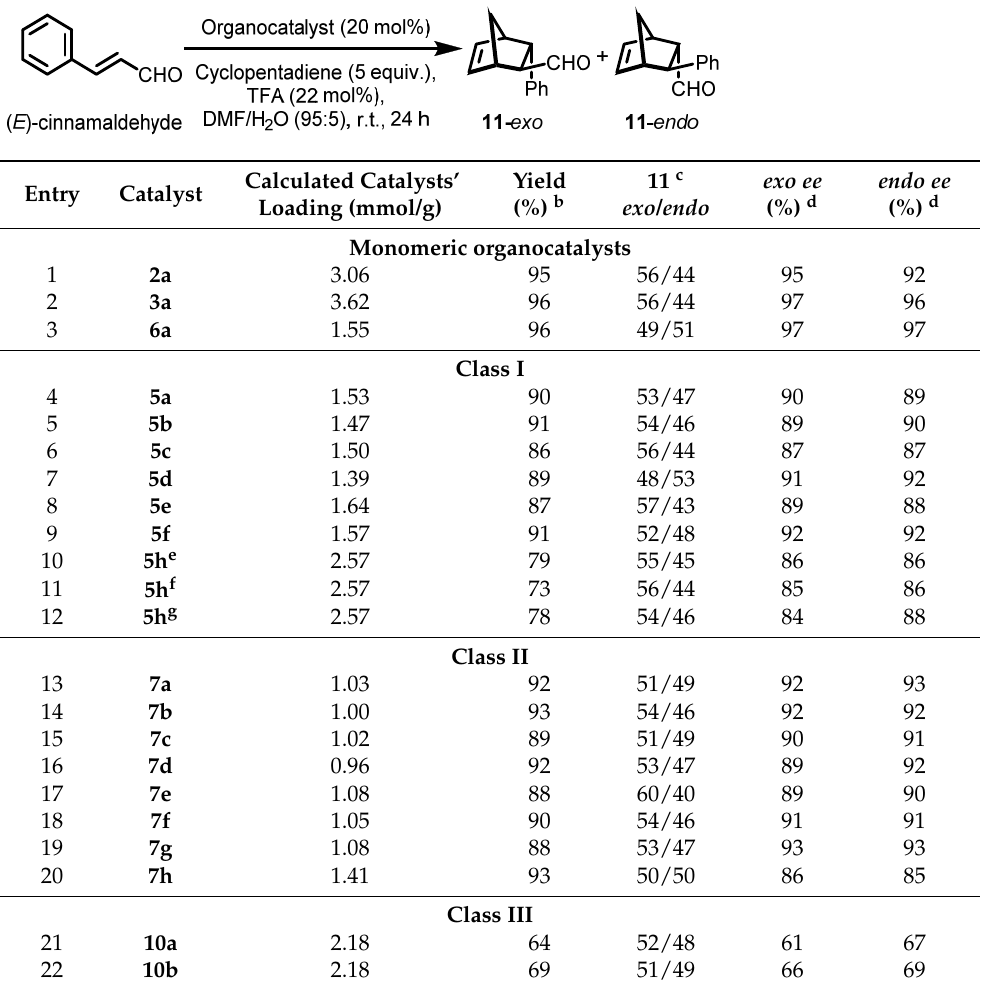
Table 5. Asymmetric Diels–Alder reaction with monomeric 2a , 3a , and 6a , and polymeric organocatalysts Class I – III a .